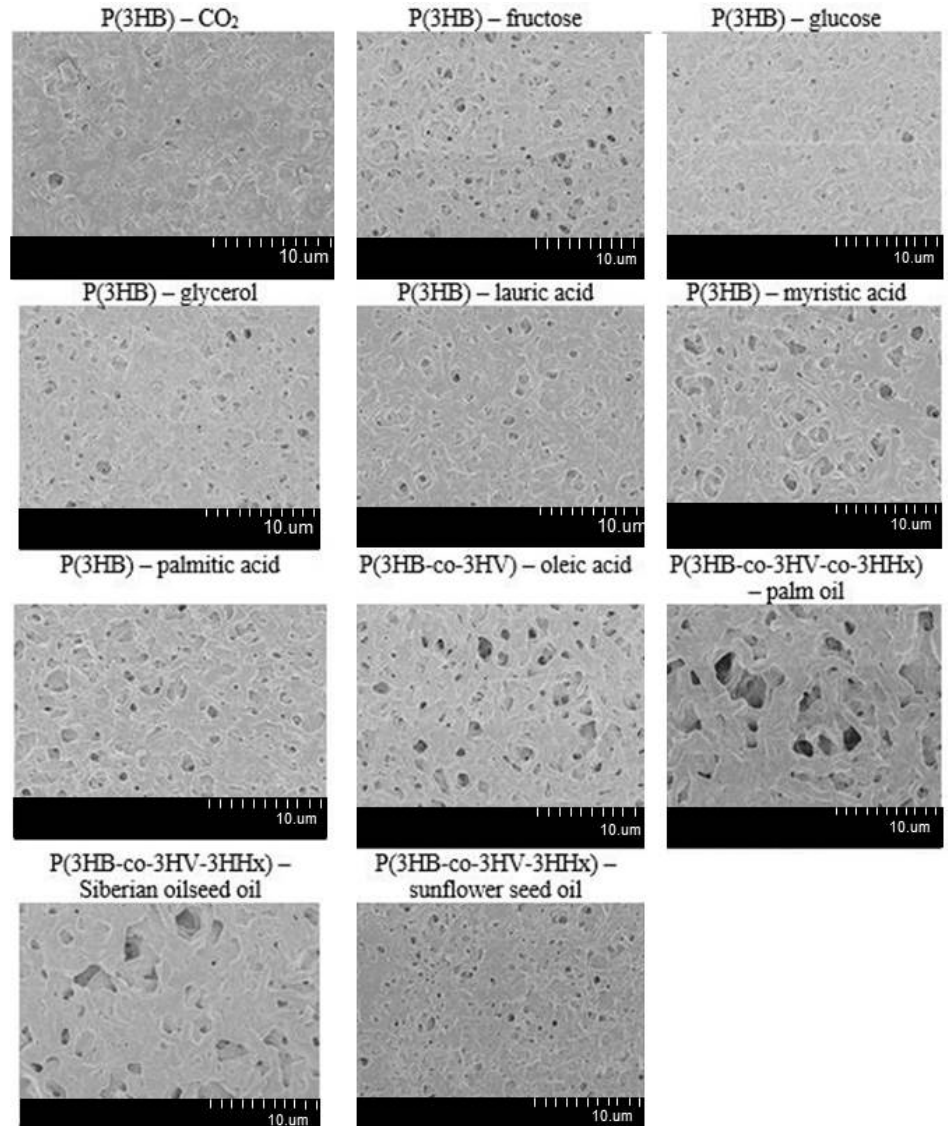
Figure 5. SEM images of the films fabricated from PHA synthesized from different carbon sources by Cupriavidus necator